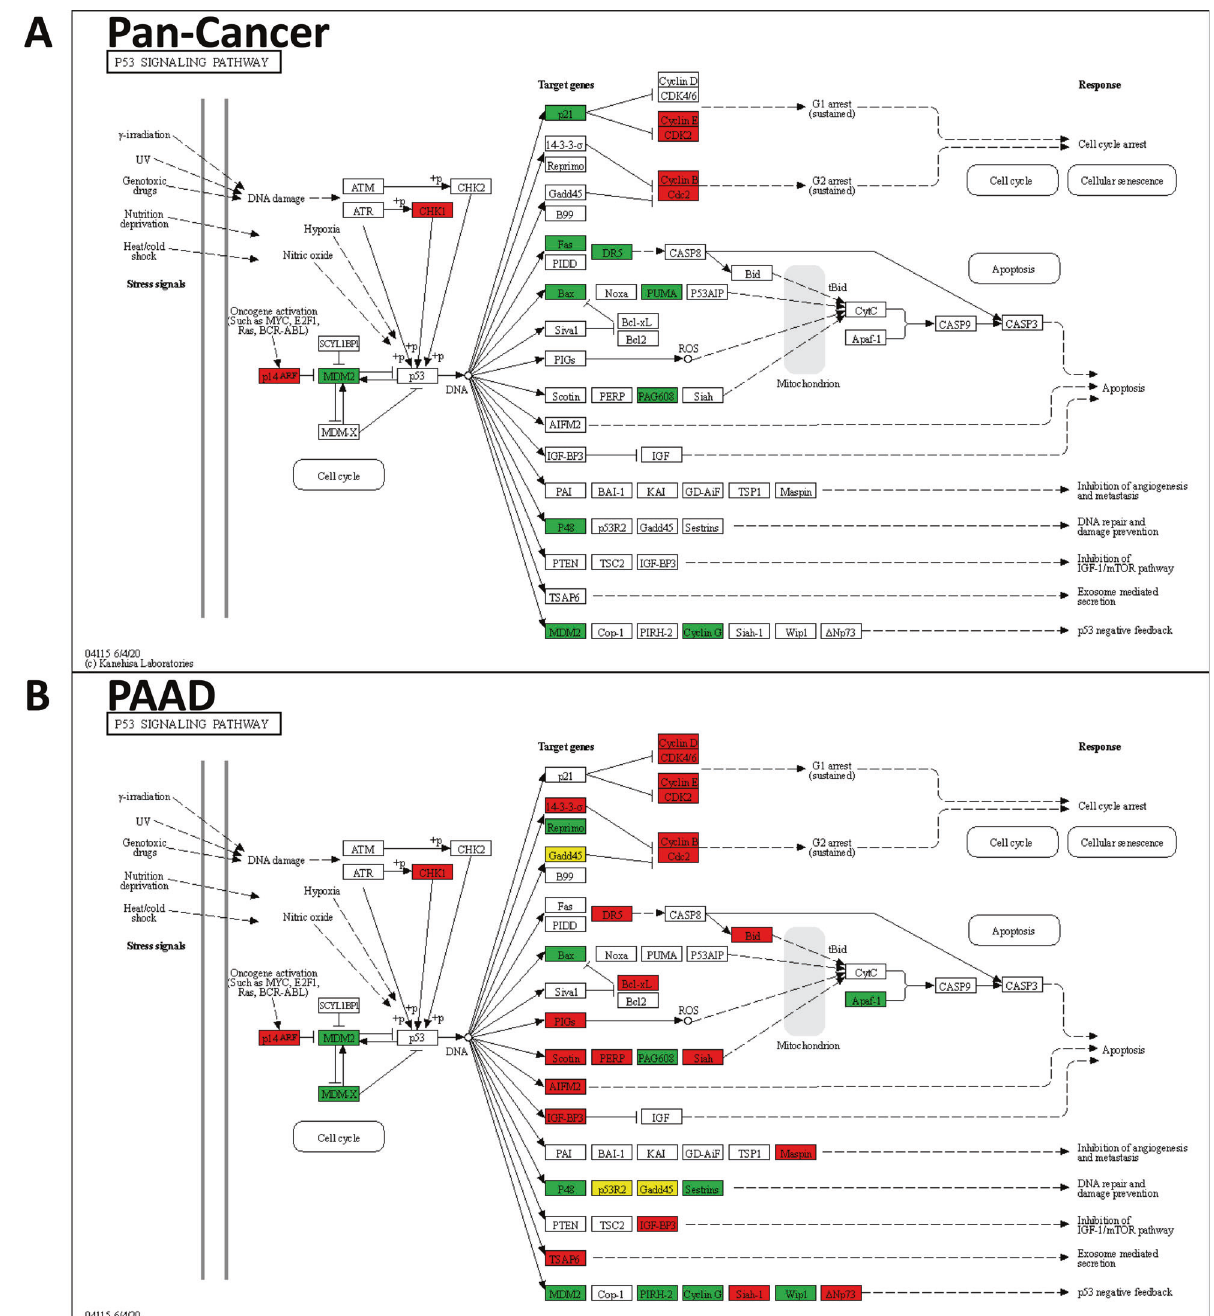
Fig. 5 Signi fi cant gene expression changes between TP53mut and TP53wt tumors in the p53 signaling pathway. A pan-cancer consensus list. B pancreatic adenocarcinoma (PAAD). Red = overexpressed in TP53mut tumors. Gree n = underexpressed in TP53mut tumors. Yellow = over- and underexpressed